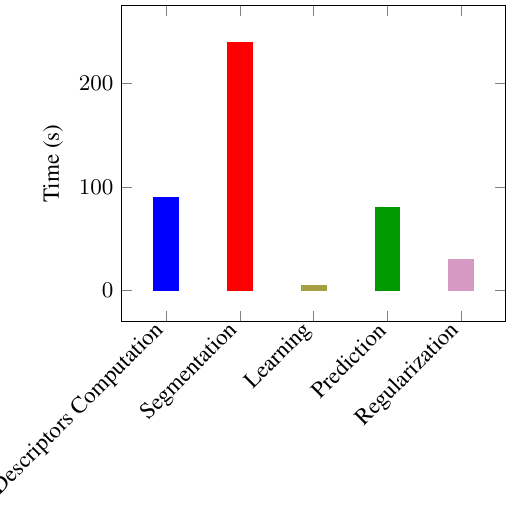
Figure 5. Processing times per